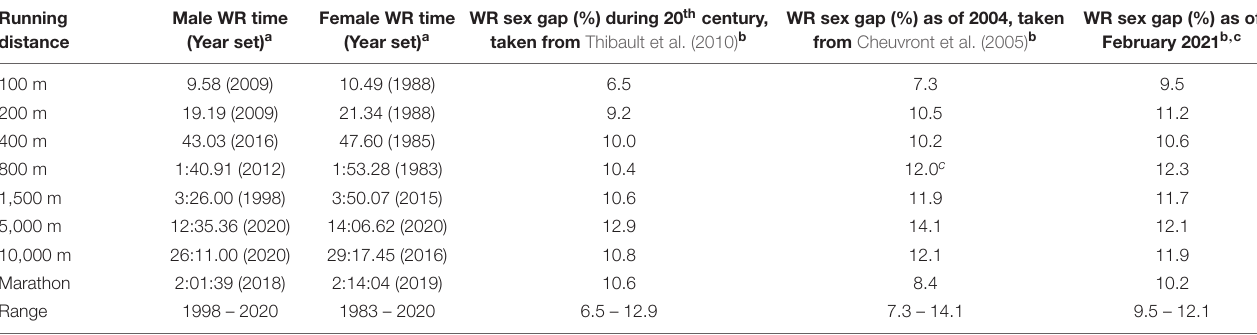
TABLE 1 | The World Record (WR) times and year for Males and Females, and the WR Sex Gap for Running Events 100 m to Marathon (Cheuvront et al., 2005; Thibault et al., 2010). Running